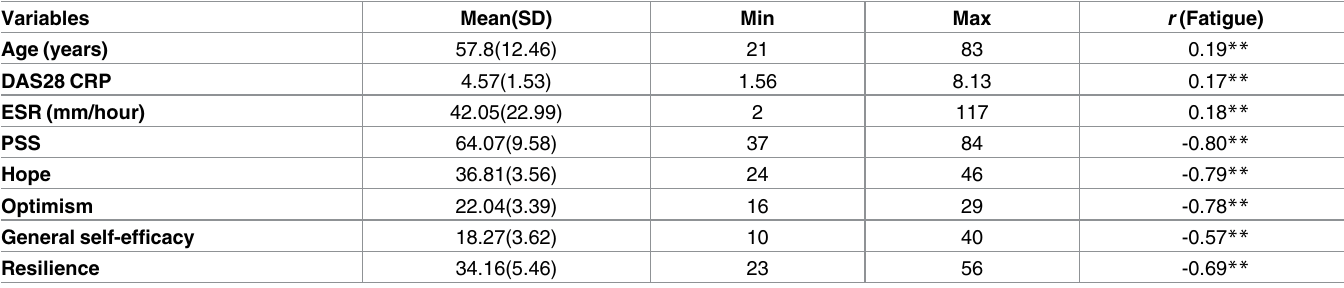
Table 2. Correlations among continuous